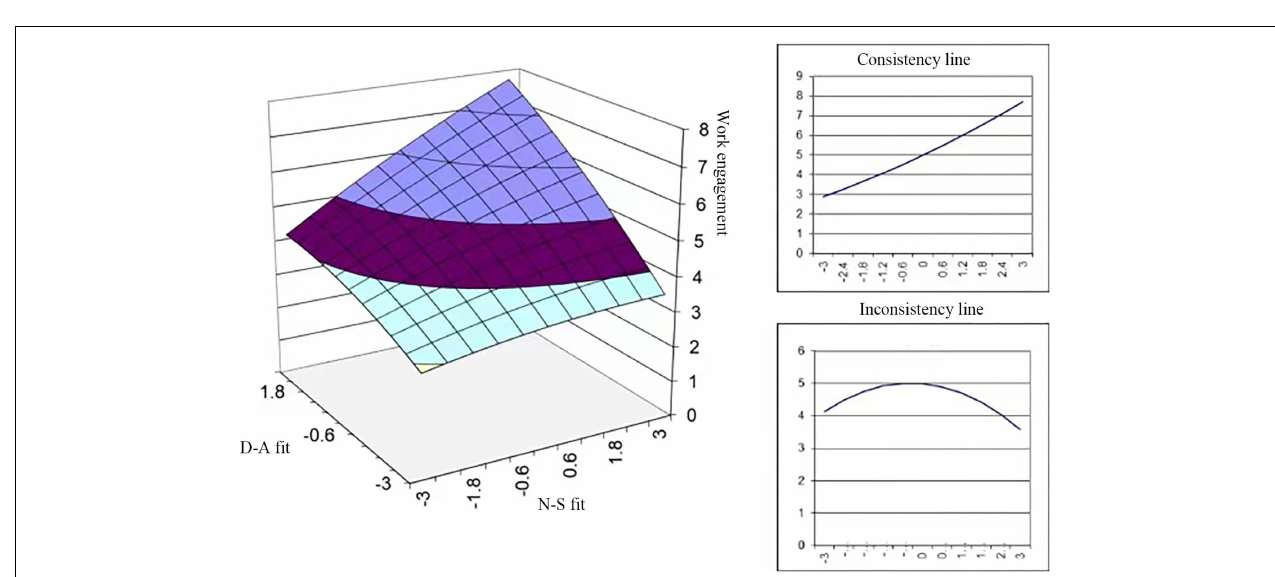
FIGURE 2 | Effects of P-E fit on work